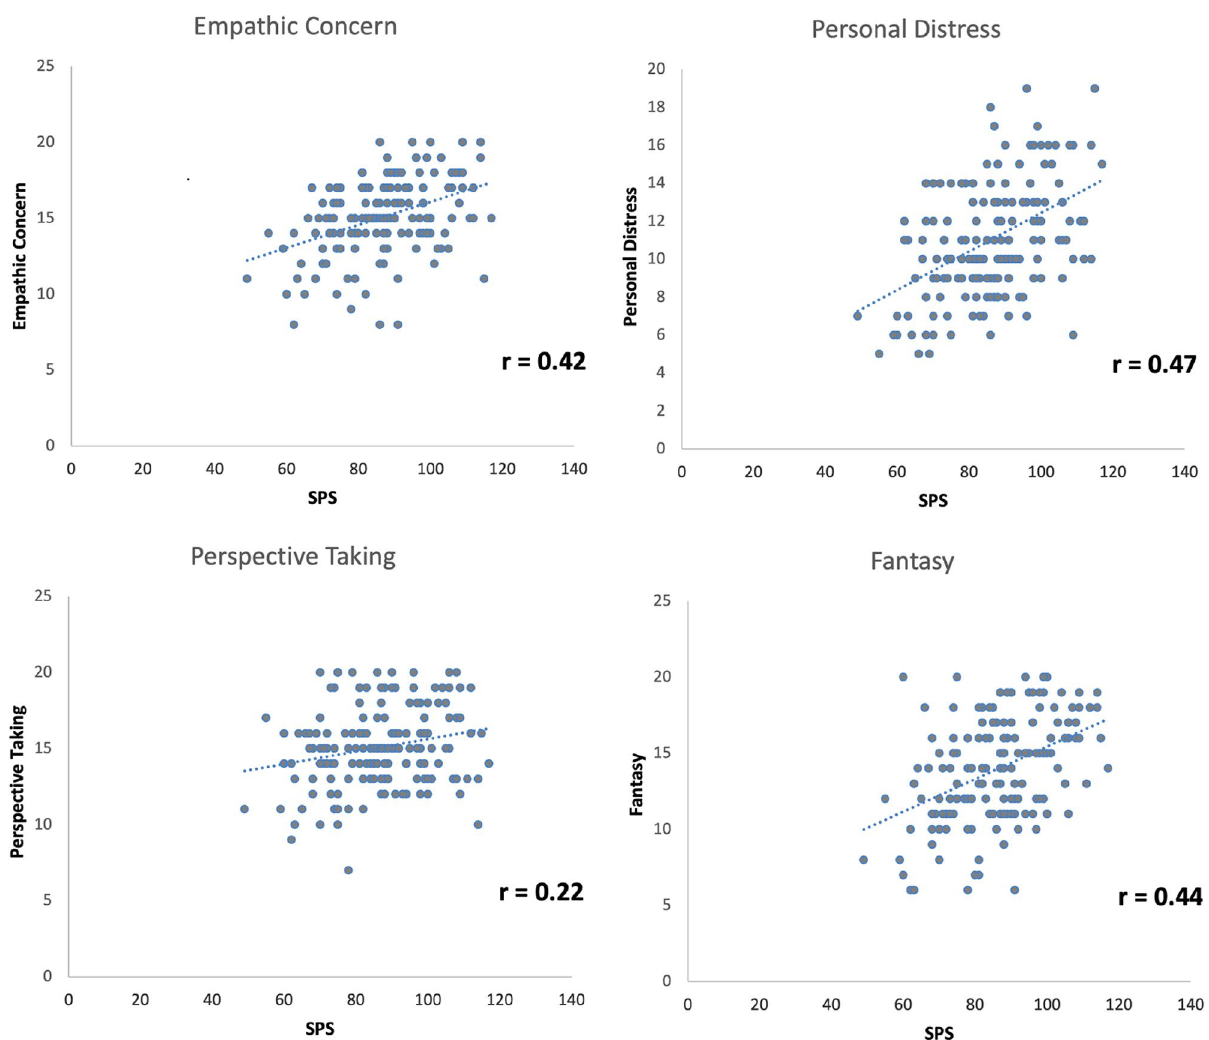
Figure 2. Scatterplots of SPS and empathy measures (IRI). Figure shows significant positive correlations for all empathy subdimensions (Pearson